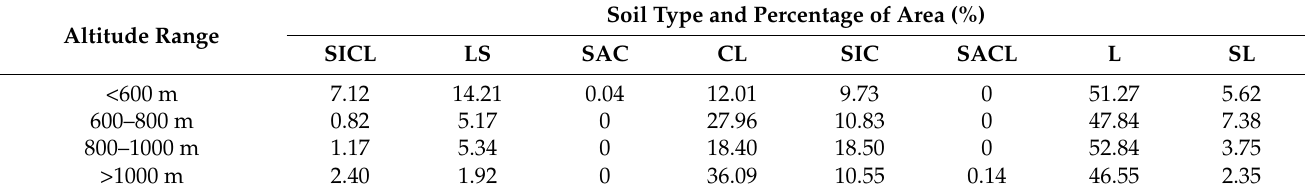
Table 3. Soil structure in different altitude